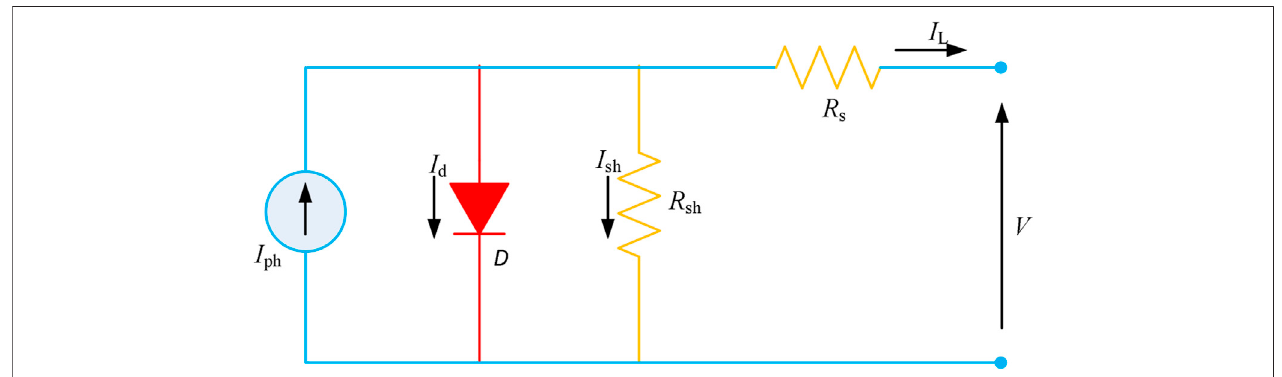
FIGURE 1 | Equivalent circuit of